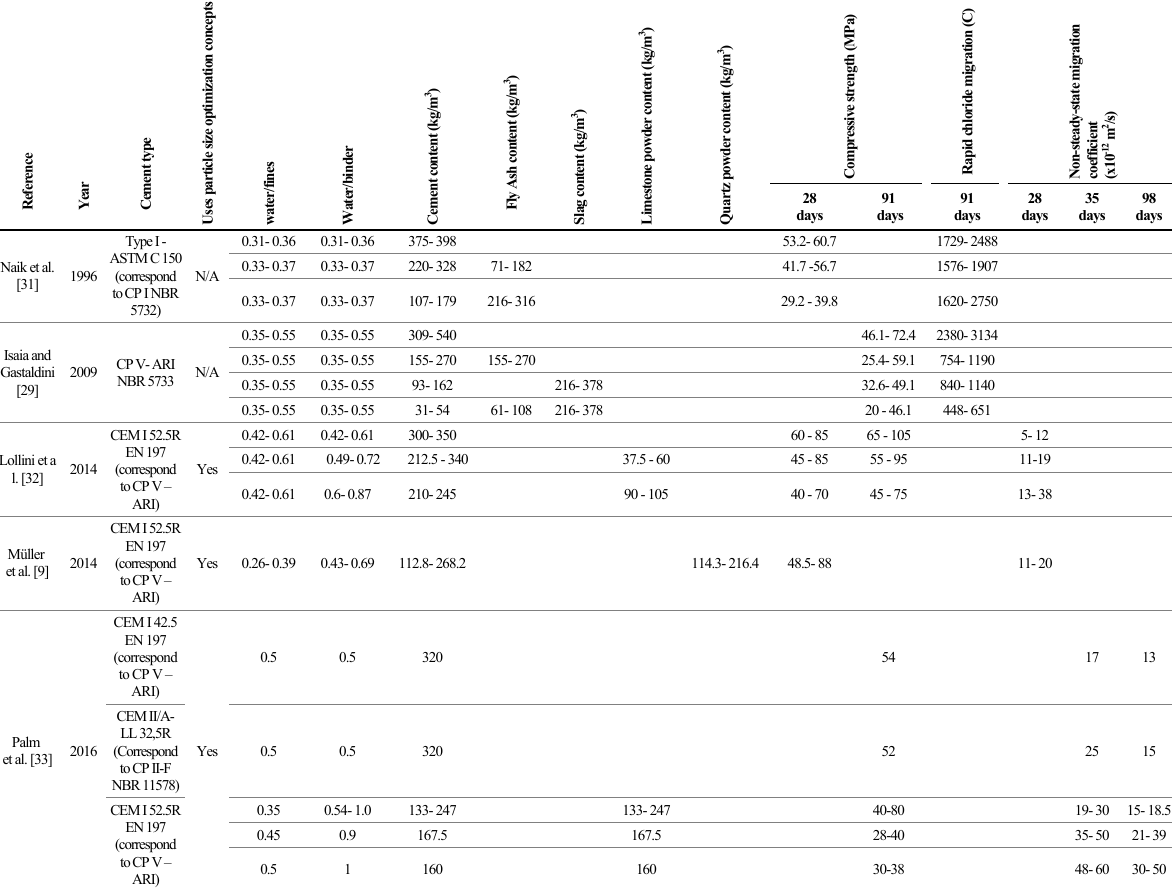
Table 2. Literature data on concrete with low cement consumption - mechanical strength and chloride